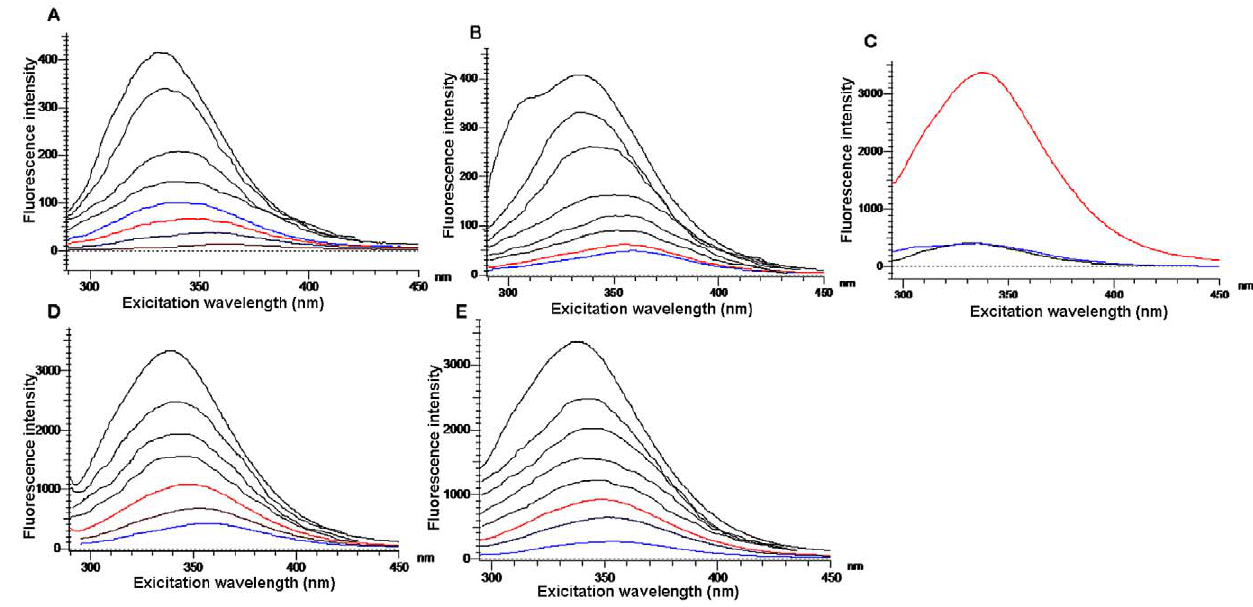
Figure 8. Effect of PE on fluorescence spectra in different protein solutions. A) Effect of FP on fluorescence spectra of CaM. B) Effect of FP on fluorescence spectra of PDE; C) Enhanced fluorescence spectra of CaM and PDE in presence of Ca 2 + . D) Effect of FP on fluorescence spectra of CaM-Ca 2 + -PDE at 37 u C. E) Effect of FP on fluorescence spectra of CaM-Ca 2 + -PDE at 25 u C. doi:10.1371/journal.pone.0036652.g008 PLoS ONE |